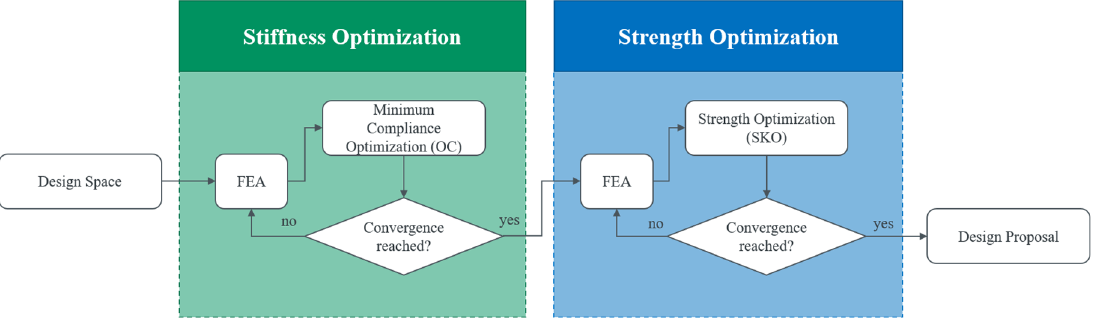
Figure 2. Concept of the TOSS algorithm, re-drawn from [2].